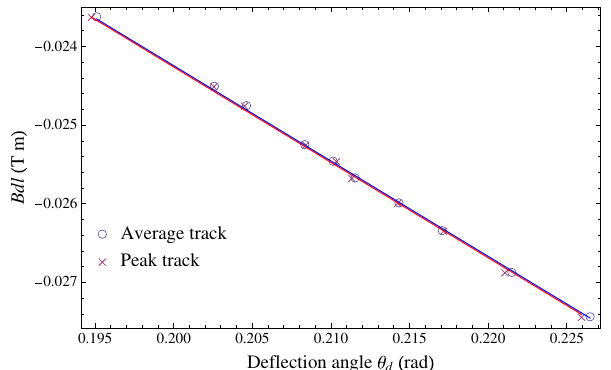
R Bd l required for the FIG. 12. The plots here show the size of given deflection angle θ d . The circled points are the data when the peak of the angular distribution shown in Fig. 13 is tracked, while crossed symbol points are the data when the mean is tracked. The slope of the plot yields B ρ . In this case, tracking either the peak or the mean of the distribution gives the same slope.